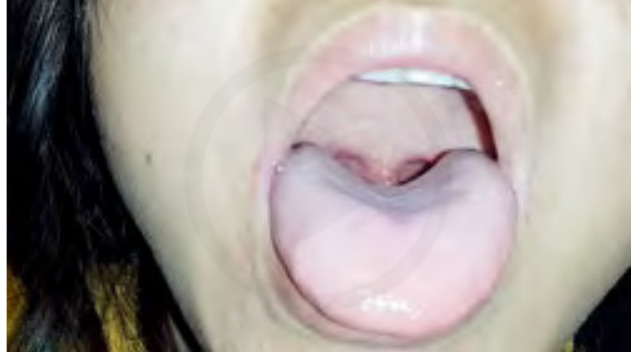
Fig 1 : Examination of palatal myoclonus. Click over the figure to see the video (available online and opens in a web